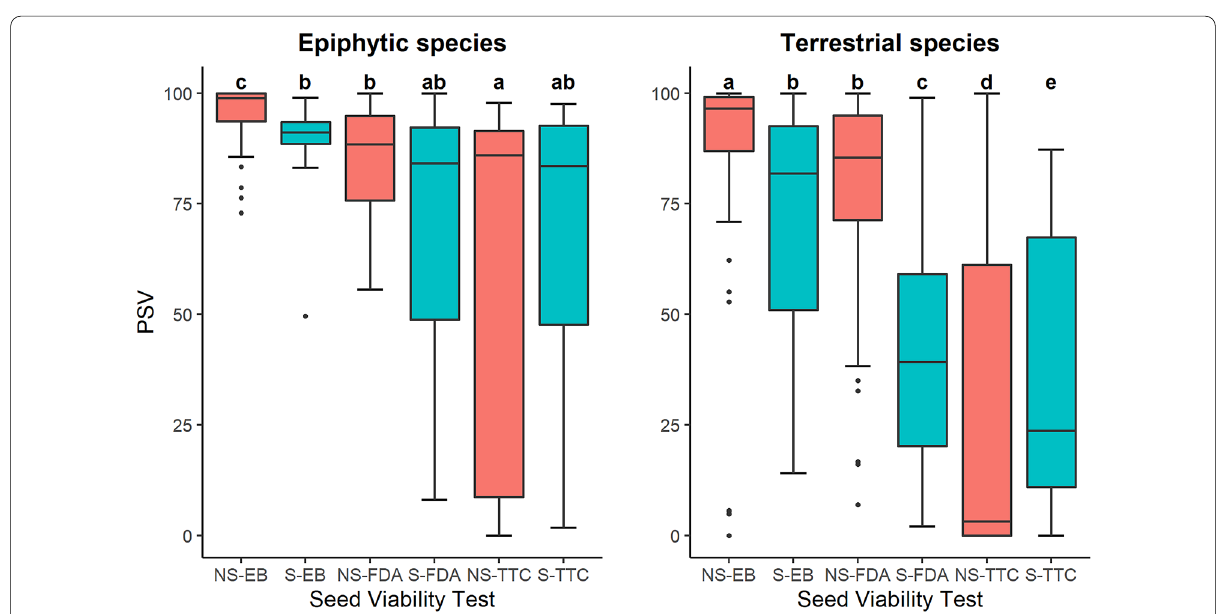
Fig. 3 Box plots for the probability of finding viable seeds (PSV) after subjecting to three seed viability tests; Evans blue test (EB), Fluorescein diacetate test (FDA) and Tetrazolium test (TTC) for epiphytic and terrestrial orchids without sterilization (NS) and with sterilization (S) of seeds. Viability tests that are marked with the same letters were similar statistically ( P > 0.05) while those with different letters were